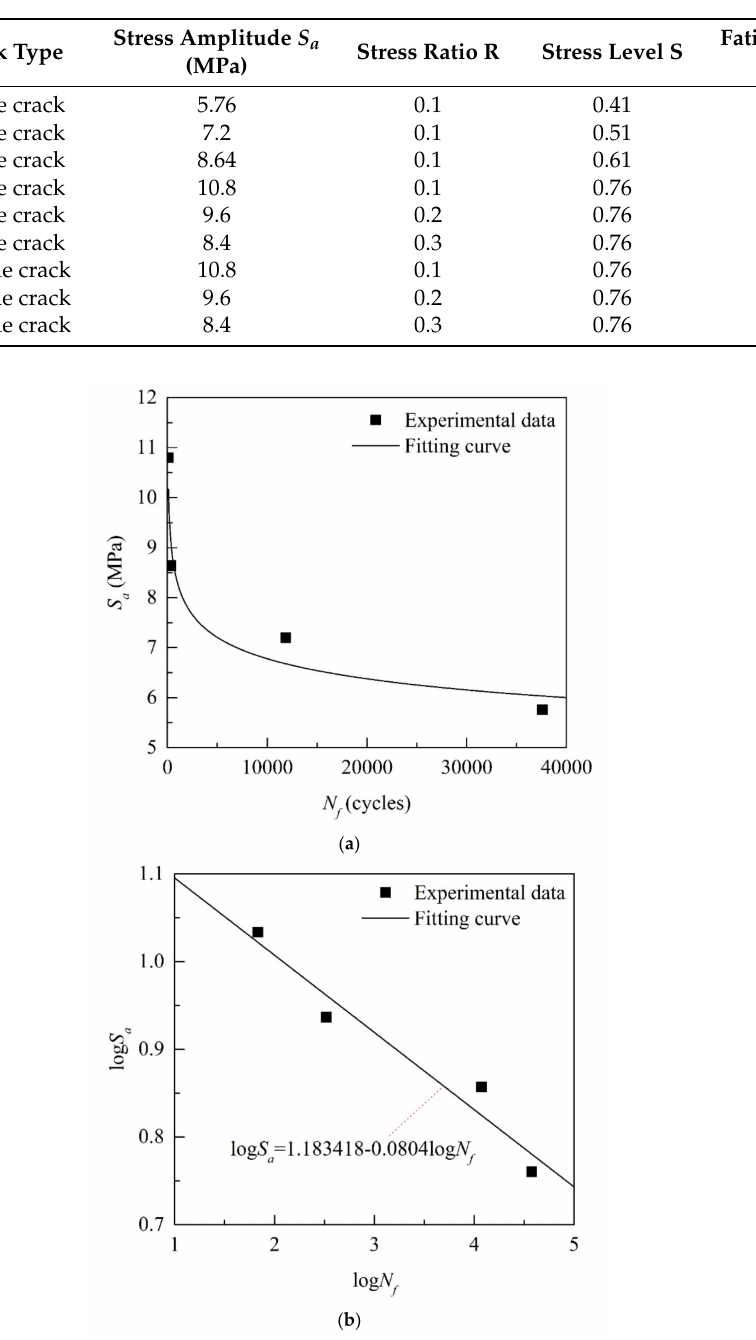
Figure 5. S-N (stress amplitude and fatigue relationship) curve (single-crack specimens, R = 0.1); ( a ): Nonlinear stress amplitude and fatigue relationship; ( b ): Double logarithmic linear